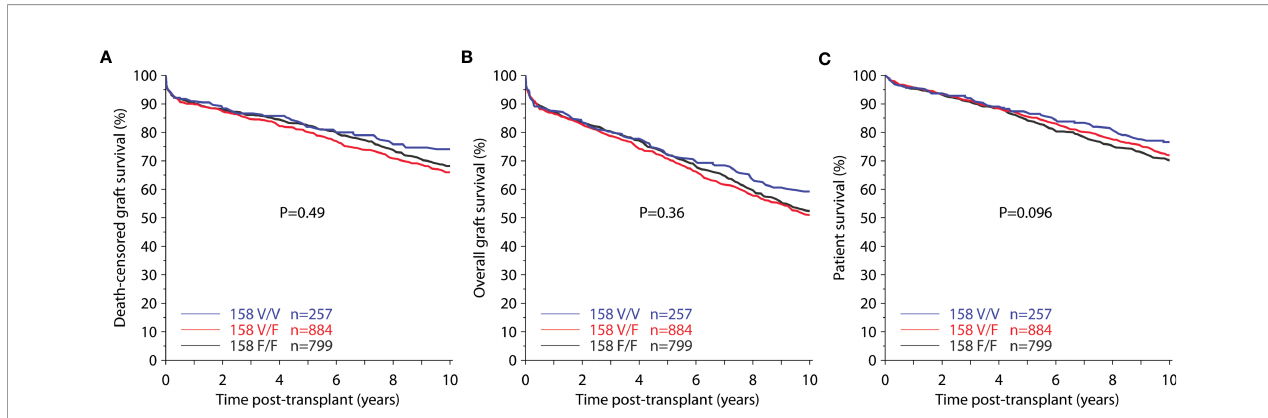
FIGURE 1 | Death-censored graft survival (A) , overall graft survival (B) , and patient survival (C) for genotypic groups of FCGR3A -V/F158 (total 1,940 recipients).